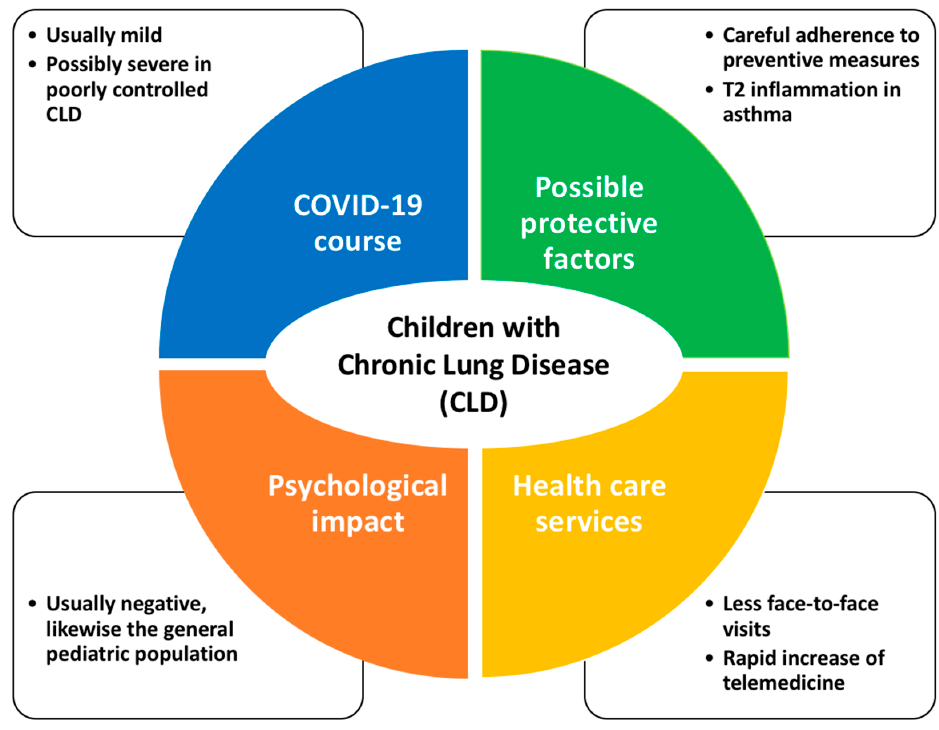
Figure 1. Features associated with COVID-19 in children with CLD.